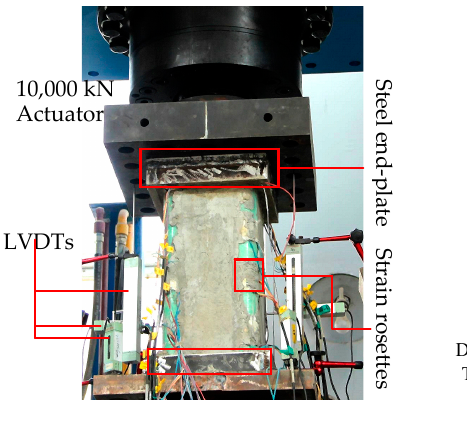
Figure 3. Test setup and instrumentation.